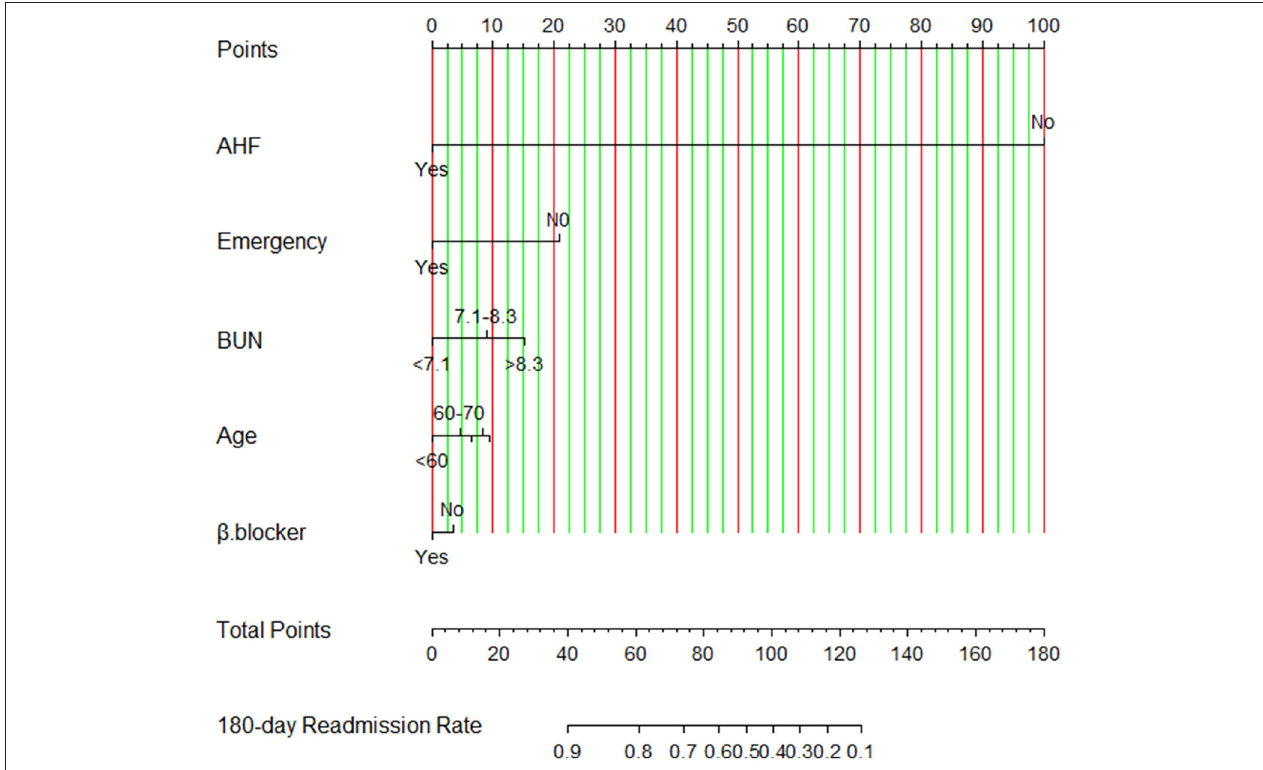
FIGURE 4 | Nomogram for risk of readmission constructed using the selected predictors. Using this nomogram, the individualized 180-day readmission risk for patients with chronic heart failure is easy to calculate. AHF, history of acute heart failure; BUN, blood urea nitrogen level; β -blocker, beta-blocker usage; emergency, emergency department